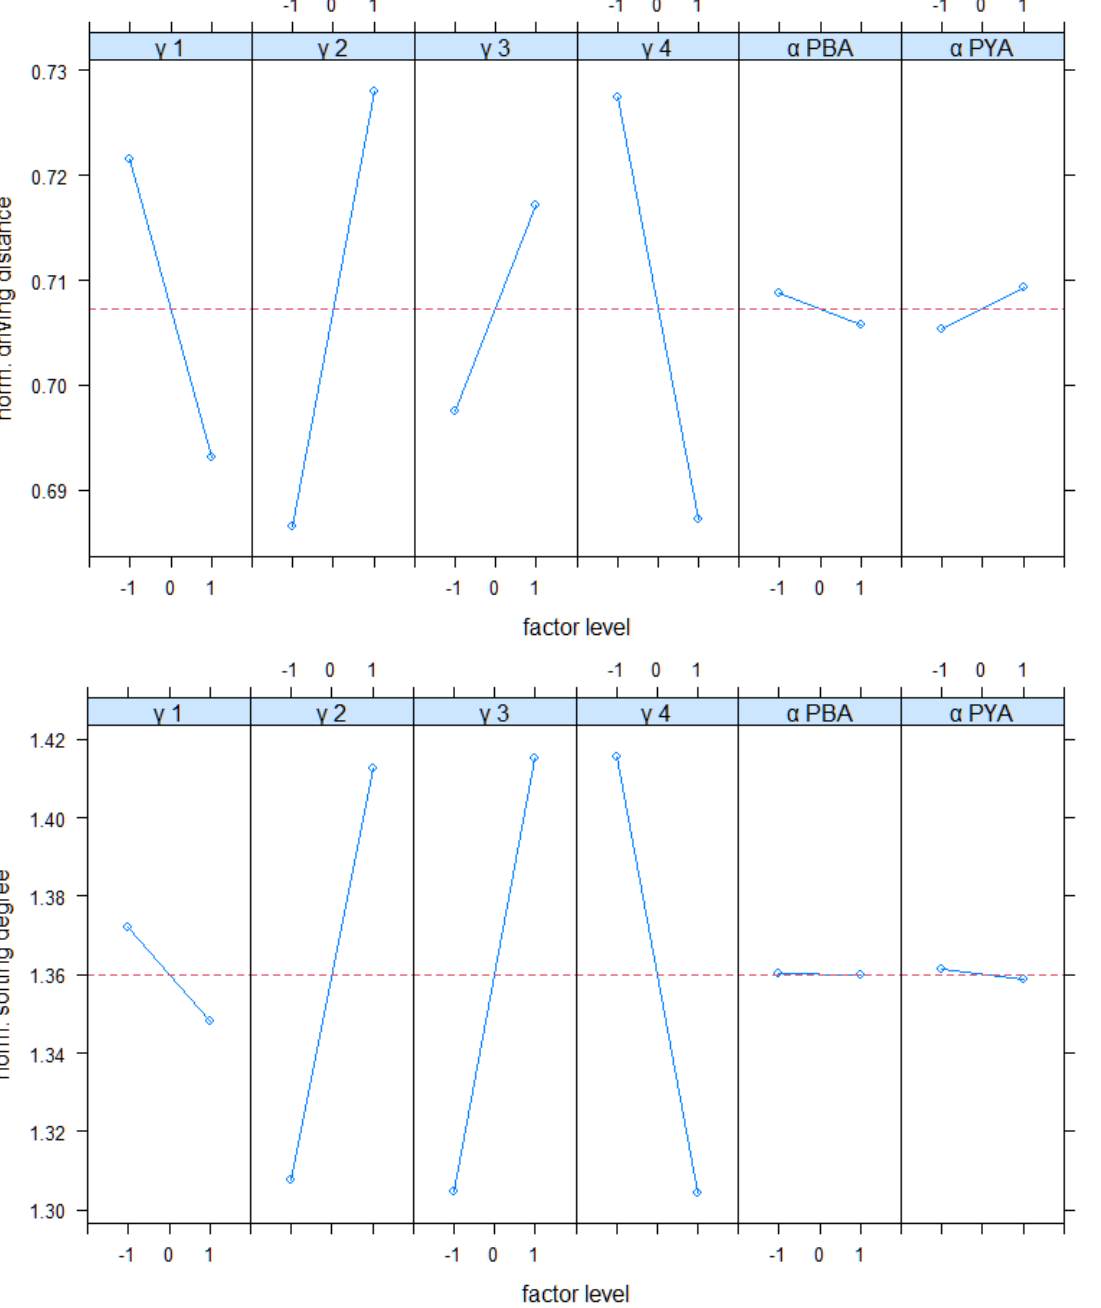
Figure 13. Main effects of FFD study in the real-data-based model.